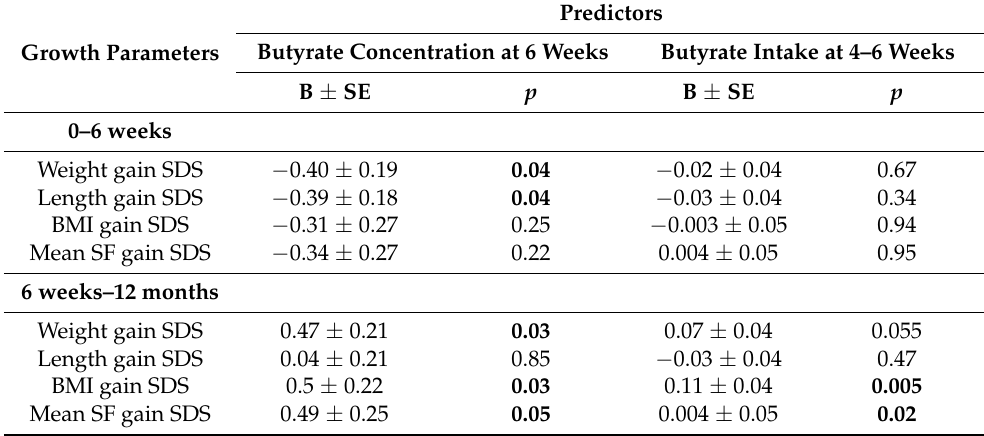
Table 4. Associations between HM butyrate concentrations/intakes and infant growth